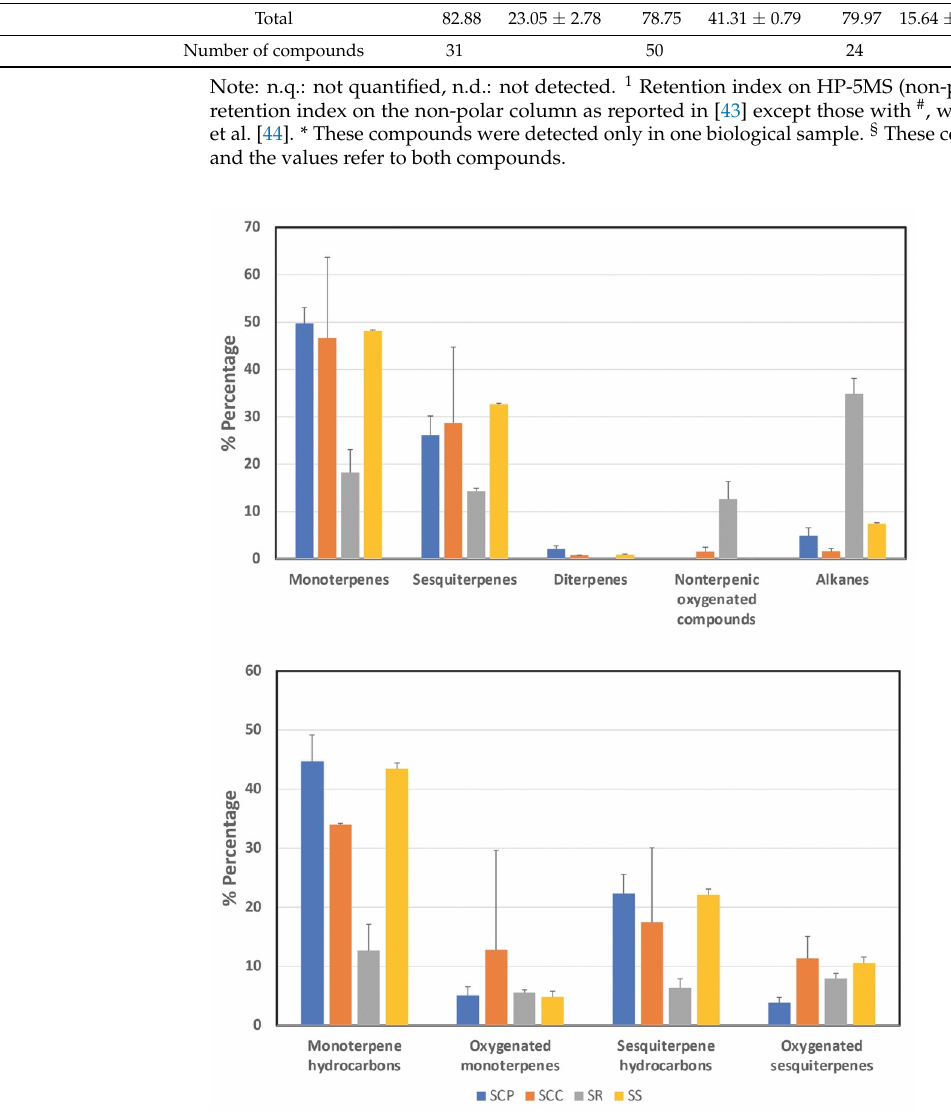
Figure 2. The content of each volatile category in the petroleum ether extracts of the four Sideritis taxa (2 biological samples per taxon, n = 2). The values of the percentage of peak areas (average